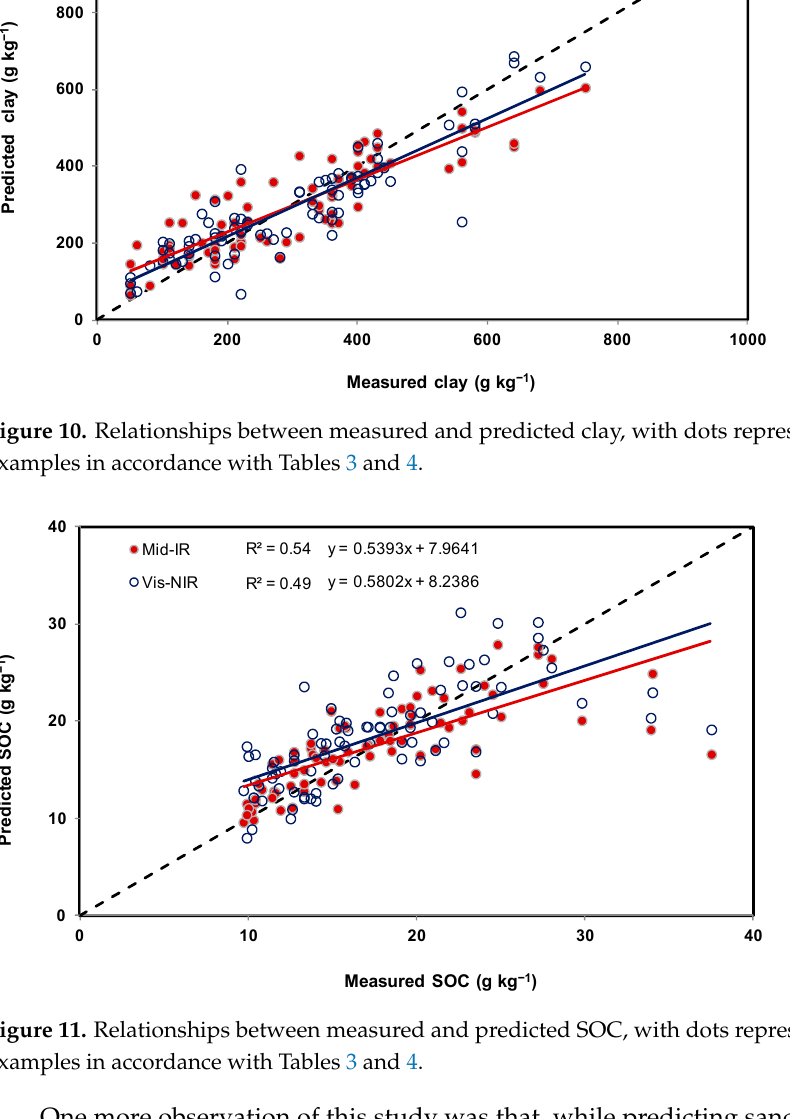
Figure 11. Relationships between measured and predicted SOC, with dots representing validation examples in accordance with Tables 3 and 4.